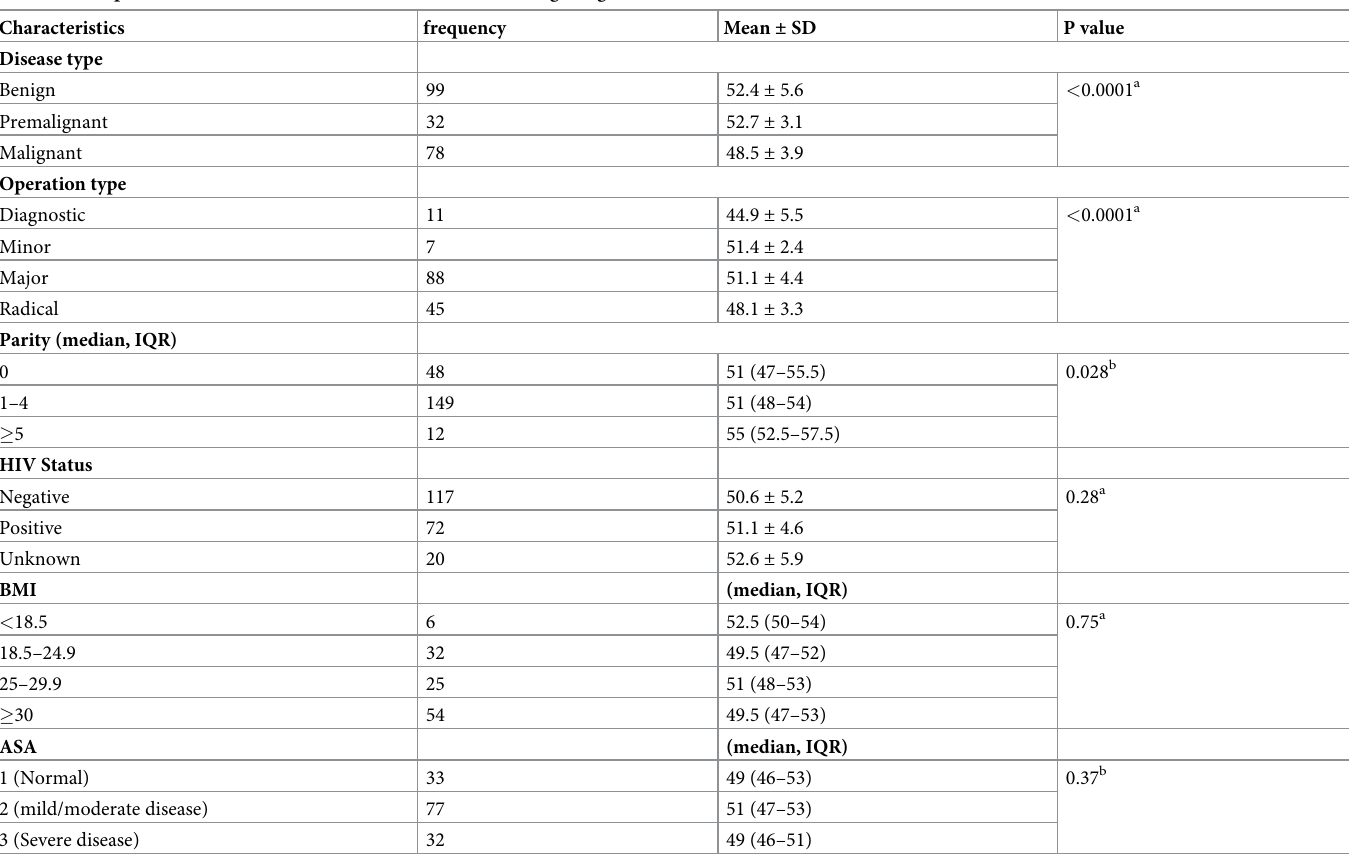
Table 3. Comparison of the cumulative mean MeNTS scores among categorical